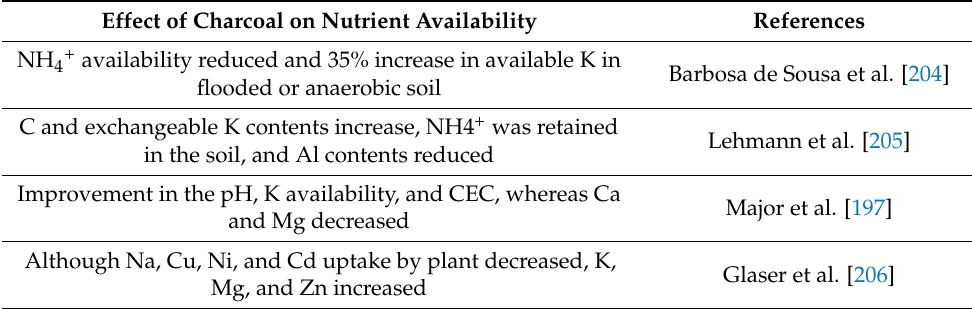
Table 3. Charcoal application on the nutrient availability in acid